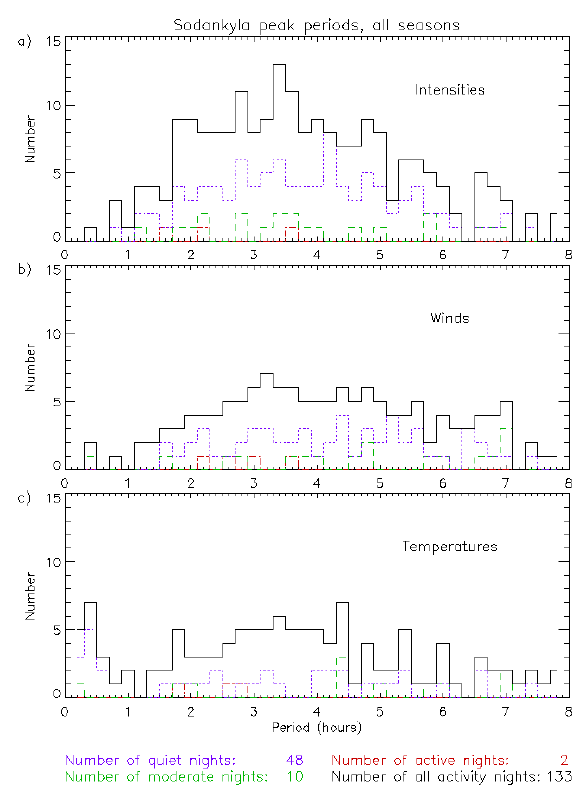
Fig. 9. Histogram of gravity wave periods for all Sodankyl¨a data (2002–2006) at all activity levels: (a) intensities, (b) winds, and (c) temperatures.